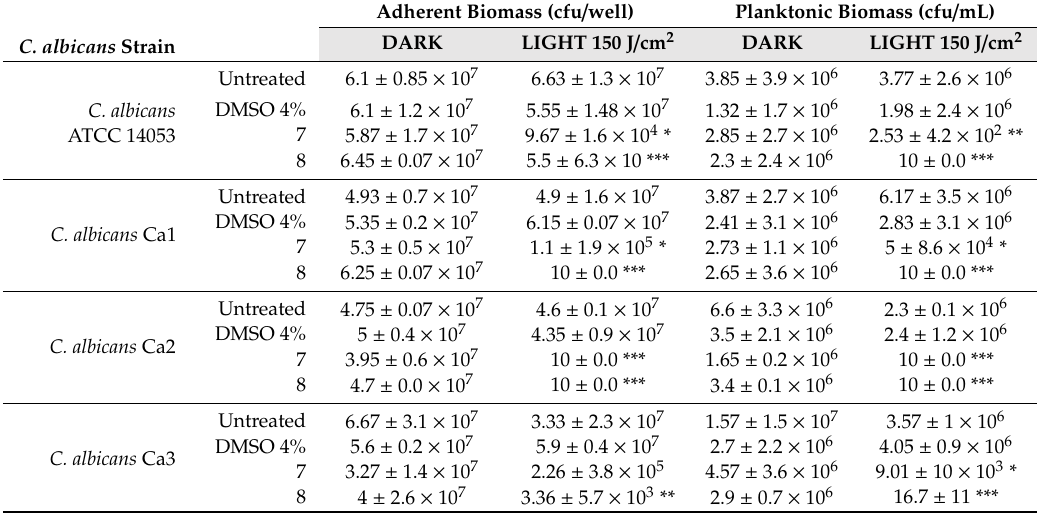
Table 2. Inhibition of the biofilm formation of four Candida albicans strains (ATCC 14053, Ca1, Ca2, and Ca3) by photodynamic inactivation with Porphyrins 7 and 8 . Porphyrins were activated by 410 nm blue light, 100 mW / cm 2 for 25 min, corresponding to 150 J / cm 2 . The table reports the results of the viable count of yeast cells belonging to adherent (cfu / well) and planktonic (cfu / mL) populations of the biofilm. Data are presented as the mean of three independent experiments ± the standard deviation. Statistical analyses were performed by one way ANOVA (* p < 0.05; ** p < 0.01; *** p < 0.0001). Adherent Biomass (cfu /